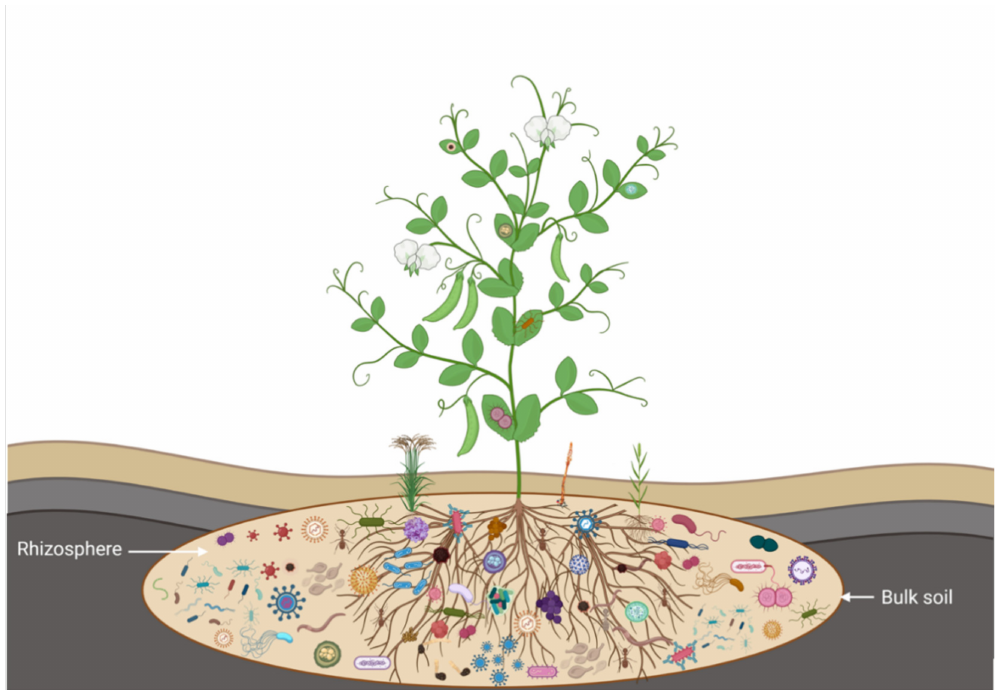
Figure 1. Rhizosphere–microbiota configuration in pea roots showcasing a multitude of interactions. Represented here are mutual associations such as rhizobia bacteria and host pea nodules—fixing nitrogen for pea growth while pea maintains bacteria nourishment, and beneficial associations such as earthworms soil burrow activities—improving soil aeration and fertility for pea, and antagonistic associations such as parasitic broomrapes and parasitic nematodes affect pea production. (Illustration made in